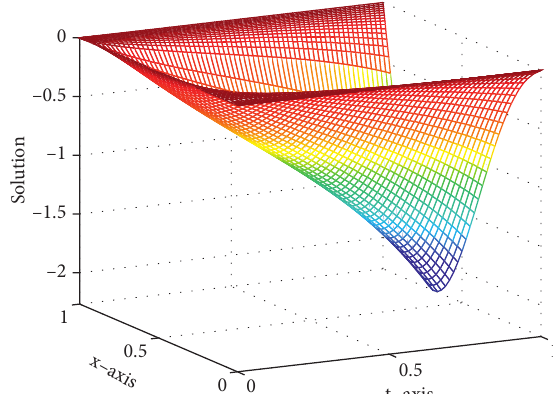
Figure 2: The numerical solution profile for Example 2 when N � 64 , M � 64 , ε � 10 − 2 , and μ � 10 − 10 .